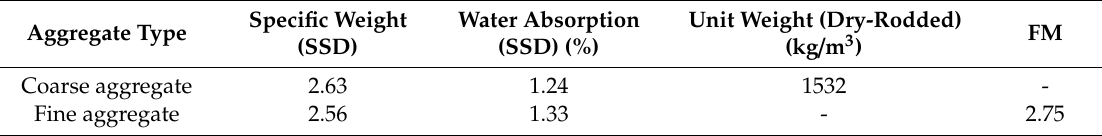
Table 1. Physical properties of coarse / fine aggregate.